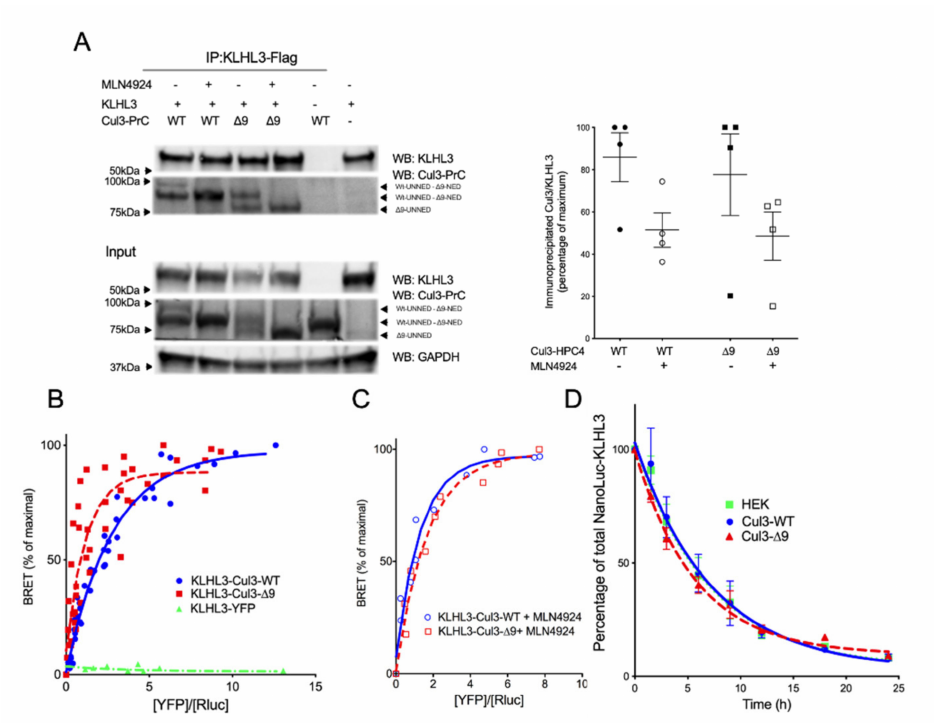
Figure 7. Dimerization, interaction and degradation of KLHL3. ( A .) Interactions of CUL3-WT and CUL3- ∆ 9 with KLHL3 Flag-KLHL3 was transfected in PrC-CUL3-WT or PrC-CUL3- ∆ 9-inducible cell lines (see Materials and Methods), induced (or not) with tetracycline (10 µ g/mL) for 16 h and treated (or not) with MLN4924 (1 µ M) for 5 h. Co-immunoprecipitation of KLHL3 was performed using M2 Flag antibodies followed by SDS-PAGE and transfer to nitrocellulose. The left shows a representative gel of the co-immunoprecipitation experiment blotted with the polyclonal HPC4 (Cell signaling) and Flag-KLHL3 (Sigma) antibodies. The bottom shows a Western blot of the same cellular extracts for CUL3, KLHL3, and GAPDH. On the left, a scatter plot of the results obtained for four experiments is presented. The results are expressed as the percentage of the maximal ratio of immunoprecipitated CUL3/KLHL3 normalized on the CUL3/GAPDH ratio observed on the input gel. Statistical comparisons used the Kruskal–Wallis test on CUL3/KLHL3 ratios and were not significant. ( B ). The interaction of Luc-KLHL3 with YFP-CUL3-WT and YFP-CUL3- ∆ 9 was analyzed with BRET experiments, as shown in Figure 2. Both CUL3-WT and CUL3- ∆ 9 strongly interacted with KLHL3 in BRET experiments, but the BRET 50 was significantly lower for CUL3- ∆ 9 (0.9115 ± 0.33) as compared to CUL3-WT(1.855 ± 0.2) ( p = 0.0478, n = 3). Statistical comparisons used the Student t test. ( C ). This twofold difference in the BRET 50 is abolished by the pretreatment of the cells with MLN4924, the inhibitor of neddylation (BRET50 = 0.9143 and 1.172 for CUL3-WT and CUL3- ∆ 9, respectively). ( D ). For KLHL3 degradation, Flp-InTM T-RExTM 293 cells stably transfected with PrC-CUL3-WT or PrC-CUL3- ∆ 9 were transfected with Nanoluc-KLHL3. Twenty-four hours post-transfection, cells were treated with tetracycline (10 ng/mL) and 12 h later with cycloheximide and collected at different time points. Luminescence of KLHL3 was measured using a Mithras LB940 plate reader. Results are expressed as the percentage of the initial luminescent signal as a function of time (h). Similar decreasing curves were observed for KLHL3 in the presence of CUL3-WT or CUL3- ∆ 9 with a half-life of 4.24 ± 0.75 h and 4.55 ± 0.58, respectively ( n = 4; p = 0.7521). The Student t test was used for statistical